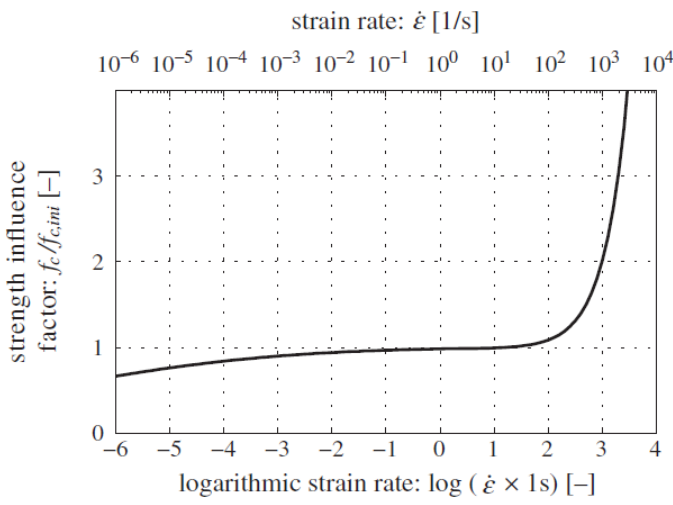
Figure 4. Factors influencing strength as a function of strain rate for a cement paste [36].